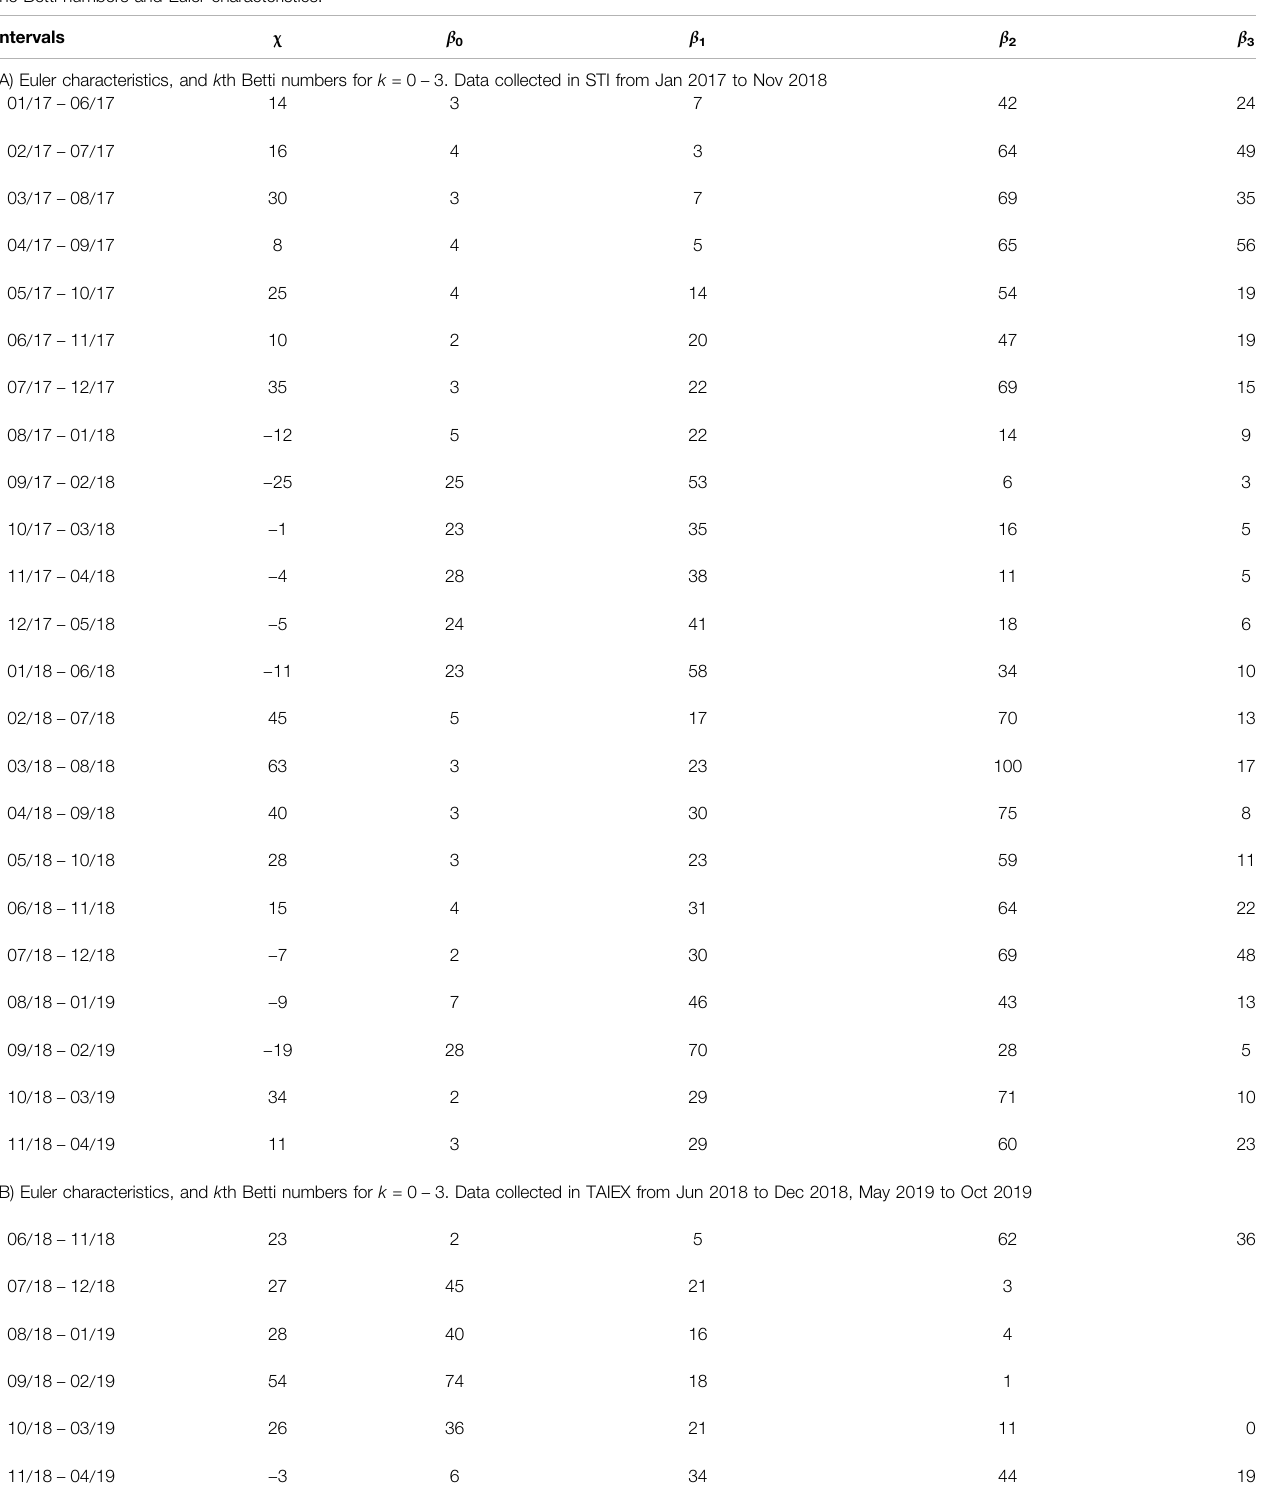
TABLE1|(A) Eulercharacteristics,and k thBettinumbersfor k (cid:1) 0 − 3.DatacollectedinSTIfromJan2017toNov2018. (B) Eulercharacteristics,and k thBettinumbersfor k (cid:1) 0 − 3. Data collected in TAIEX from Jun 2018 to Dec 2018, May 2019 to Oct 2019. Two periods cover the two crashes. We have calculated β k speci fi cally for